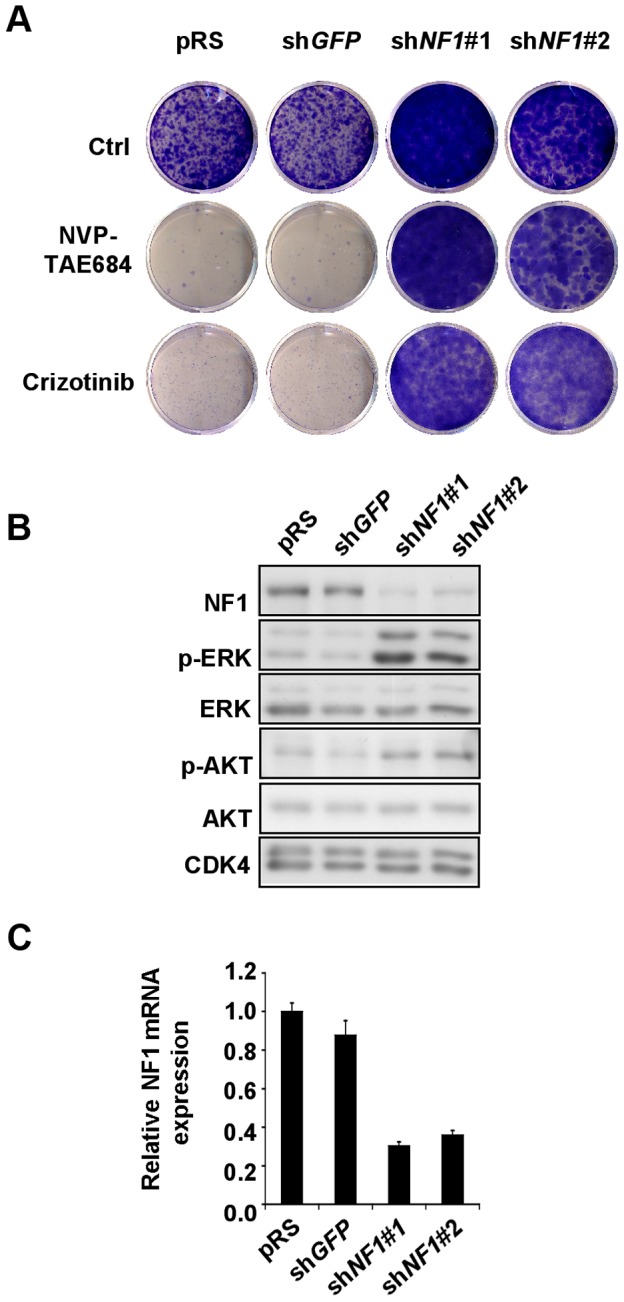

NF1 suppression leads to ERK activation and confers resistance to ALK inhibitors in human neuroblastoma cells.(A) NF1 knockdown confers resistance to ALK inhibitors in human neuroblastoma cells. SH-SY5Y cells expressing pRS and shGFP control vectors, or shNF1 vectors were grown in the absence or presence 50 nM NVP-TAE684 or 250 nM crizotinib. The cells were fixed, stained and photographed after 14 (untreated and crizotinib treated), or 21 (NVP-TAE684 treated) days. (B) Down-regulation of NF1 results in elevated level of phosphorylated p-ERK and p-AKT. Western blot analysis of total lysates of SH-SY5Y cells expressing pRS, shGFP or shNF1 vectors. (C) The level of NF1 knockdown by each of the RNAi vectors was measured by examining the NF1 mRNA levels by qRT-PCR. Error bars denote standard deviation.